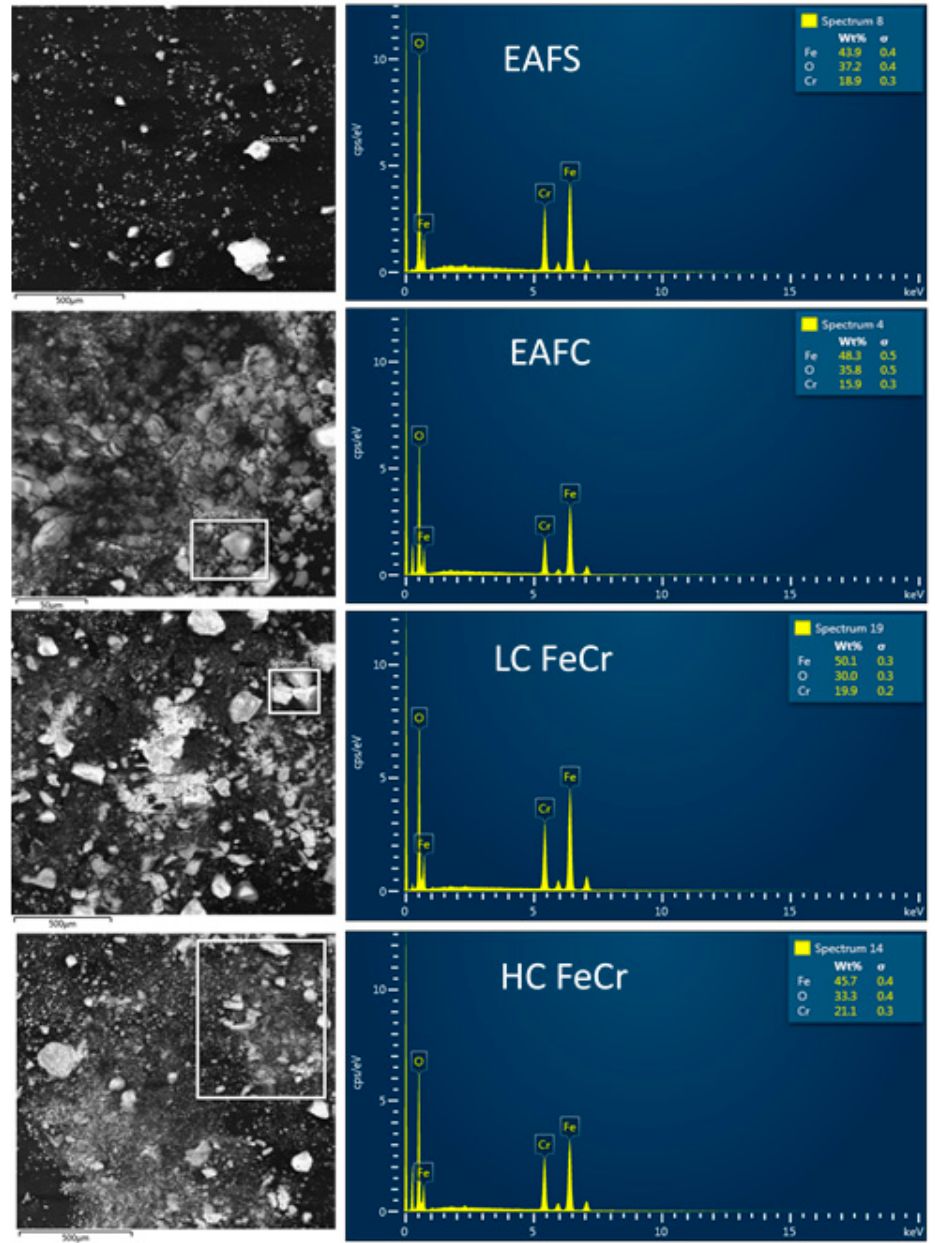
Figure 8. SEM-EDX analysis of EC solid products prepared from leachates EAFS, EAFC, LC FeCr, HCFeCr.